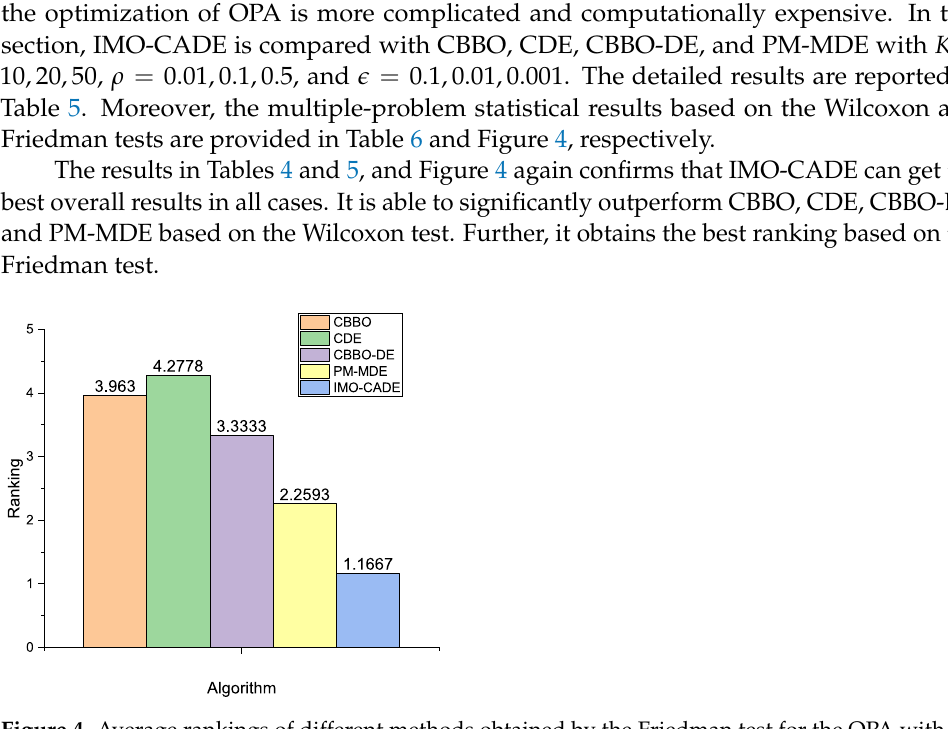
Figure 4. Average rankings of different methods obtained by the Friedman test for the OPA with the reported results under correlated observations, where the p -value computed by Iman and Daveport test is